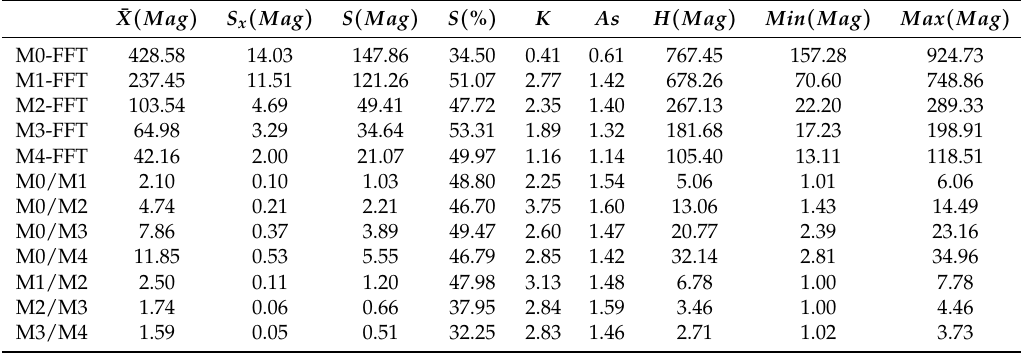
Table A6. Statistical descriptive measures of the magnitude data of the standard group of C. capitata .